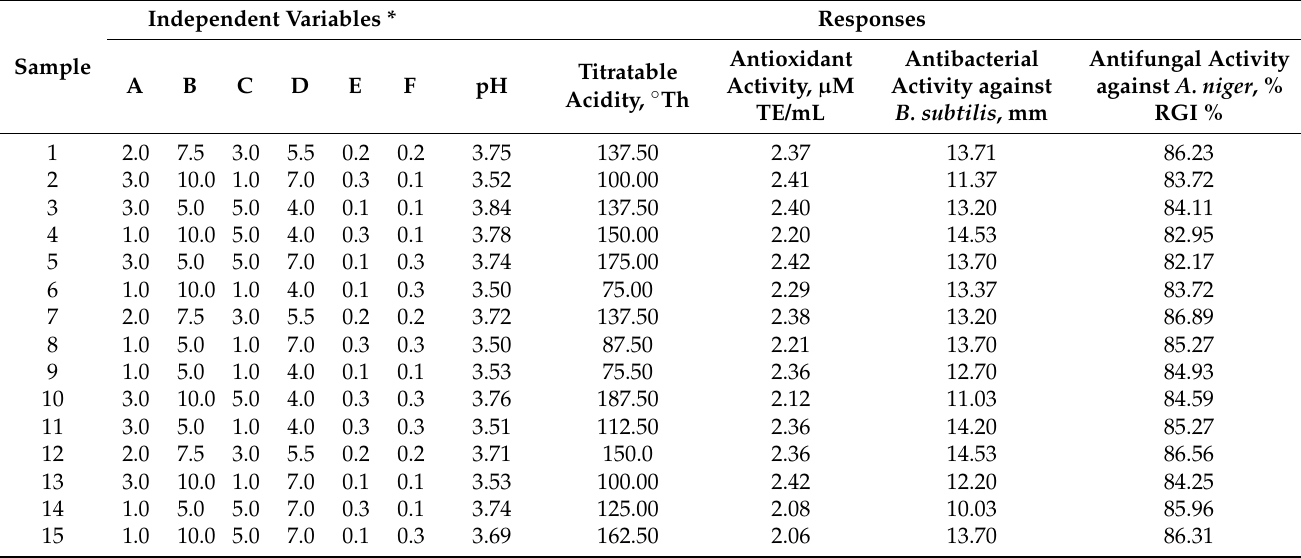
Table 3. Design of the experiments by PB analysis and the obtained responses according to the variation of the independent